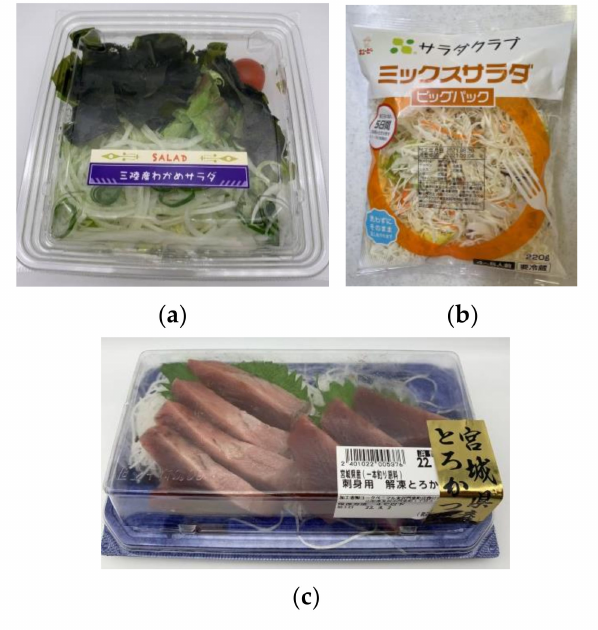
Figure 1. Examples for packages of a salad ( a , b ) and sashimi ( c